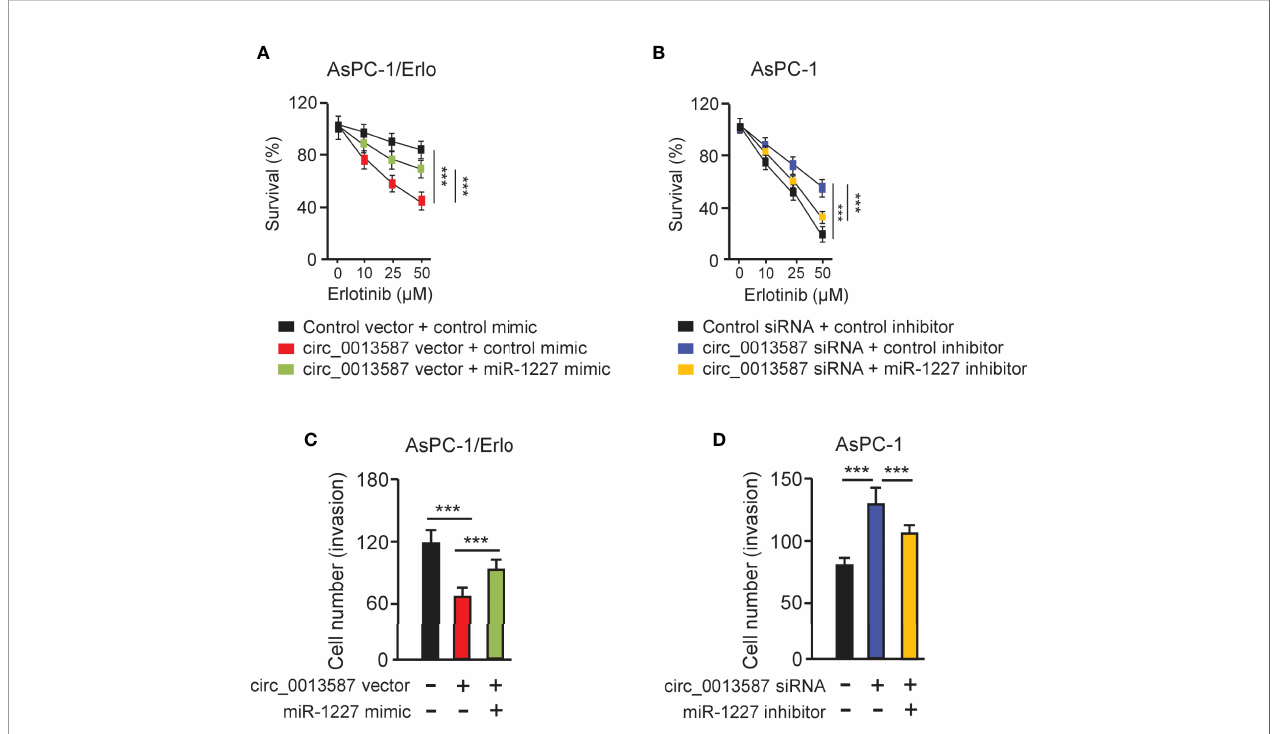
FIGURE 5 | Circ_0013587 mediates erlotinib resistance through regulating miR-1227 expression. (A, B) AsPC-1/Erlo (A) and AsPC-1 (B) cells transfected as indicated were exposed to each concentration of erlotinib for 48 h, and the inhibitory effects of erlotinib were evaluated using CCK-8 assays. (C, D) Pancreatic cancer cells were transfected as indicated and cell invasion was measured using transwell invasion assays. *** P